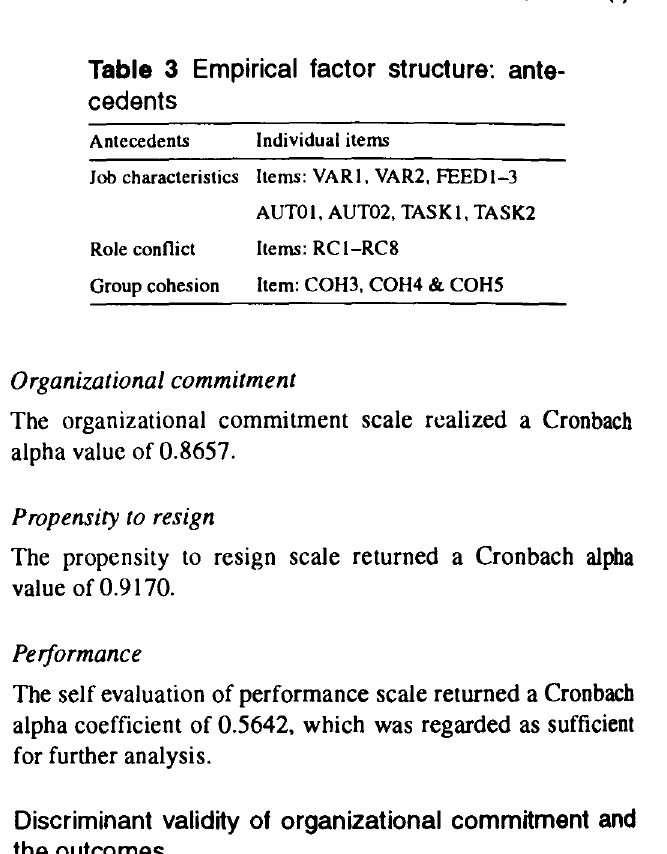
Table 3 Empirical factor structure: ante